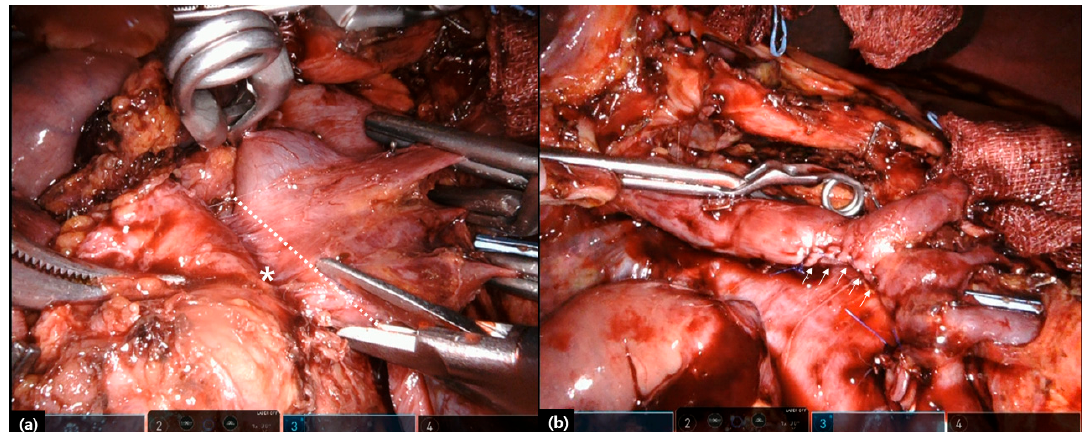
Figure 3. Combined venous vascular resection during laparoscopic pancreaticoduodenectomy (LPD). Tangential wedge resection of SMV is performed after transient clamping venous system ( a ). Primary repair of resected venous system ( b ). Tangential resection line (white dotted line), tumor invasion (white *), primary repair (white arrows).